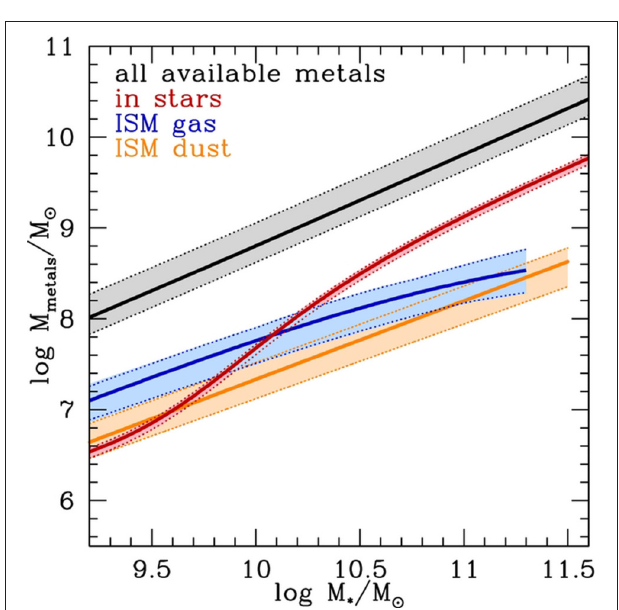
FIGURE 2 | Total mass of metals produced by supernovae and AGB stars (black), the mass of metals currently in stars (red), the mass of metals in interstellar gas (blue), and the mass of metals in dust (orange), all plotted vs. the z = 0 galactic stellar mass of star-forming galaxies. The shaded regions and dotted lines denote the adopted uncertainties (after Peeples et al., 2014, reproduced by permission of the